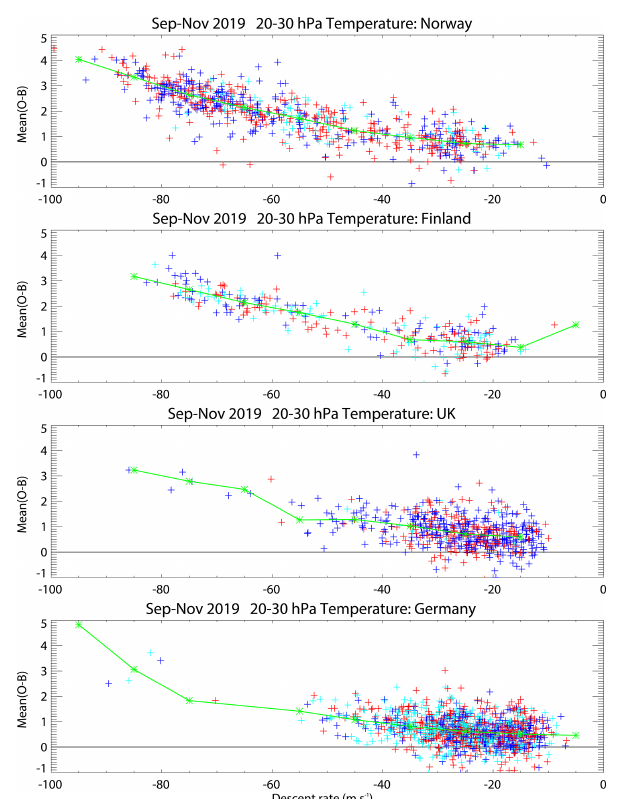
Figure 14. Comparison between the mean fall speed from 20 to 30hPa and the mean O − B temperature. Red markers denote nominal 12:00UTC profiles, dark blue markers denote nominal 00:00UTC profiles and cyan denotes intermediate profiles. (Recall that the B values have a bias of about 0.4 ◦ C at these levels.) Green markers show the values averaged over all times of the day in bins of 10ms − 1 .